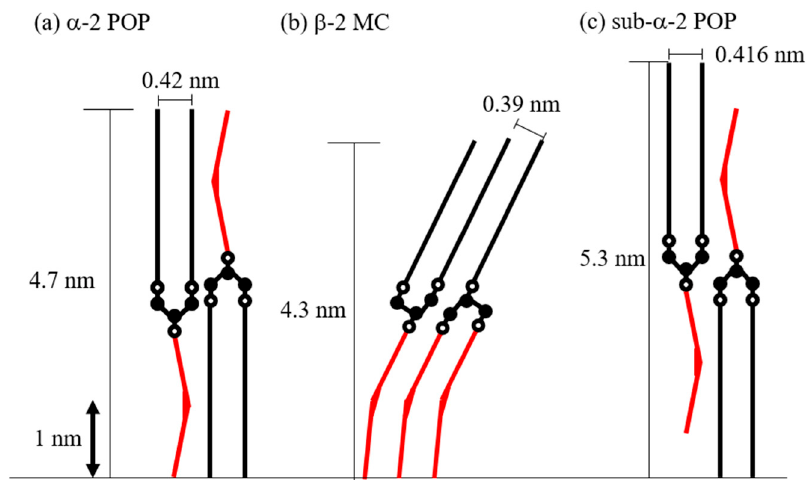
Figure 7. Schematic image of POP and MC structure models. ( a ) Structure model of α form of POP ( α -2 POP) inferred from diffraction peaks of 4.7 and 0.42 nm. ( b ) Structure model of β form of MC consisted of POP and OPO ( β -2 MC) inferred from diffraction peaks of 4.3 and 0.39 nm. ( c ) Structure model of sub- α form of POP (sub- α -2 POP) inferred from diffraction peaks of 5.3 and 0.416 nm. Closed circle: carbon atom. Open circle: oxygen atom in glycerol backbone. Straight line: palmitoyl moiety. Red bent line: oleoyl moiety.